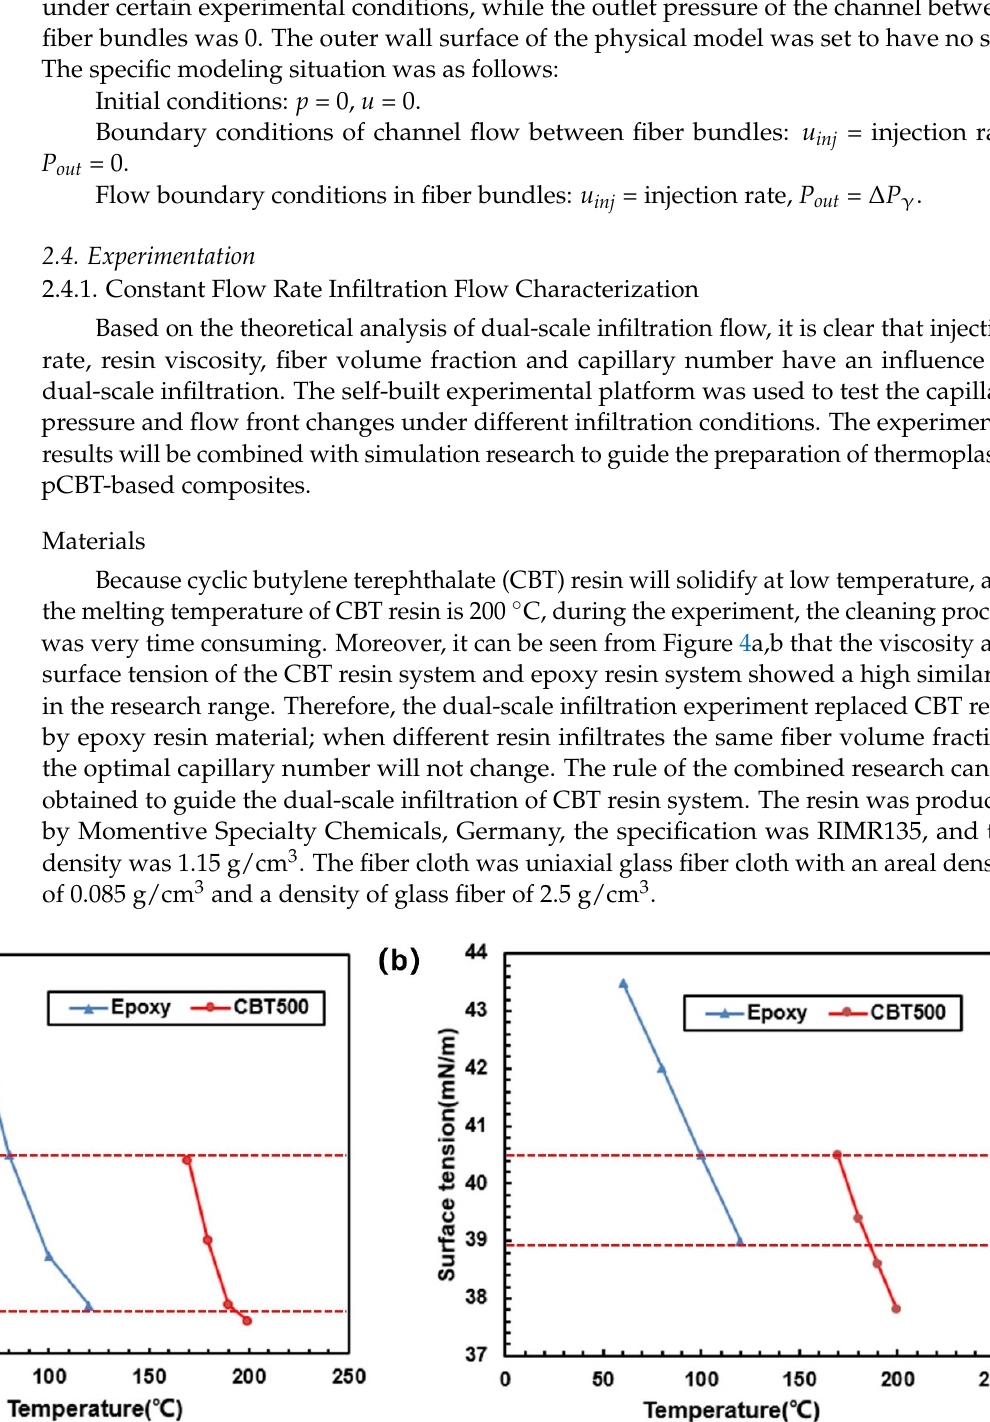
Figure 4. ( a ) The viscosity of CBT resin system and epoxy resin system. ( b ) Surface tension of CBT resin system and epoxy resin system.